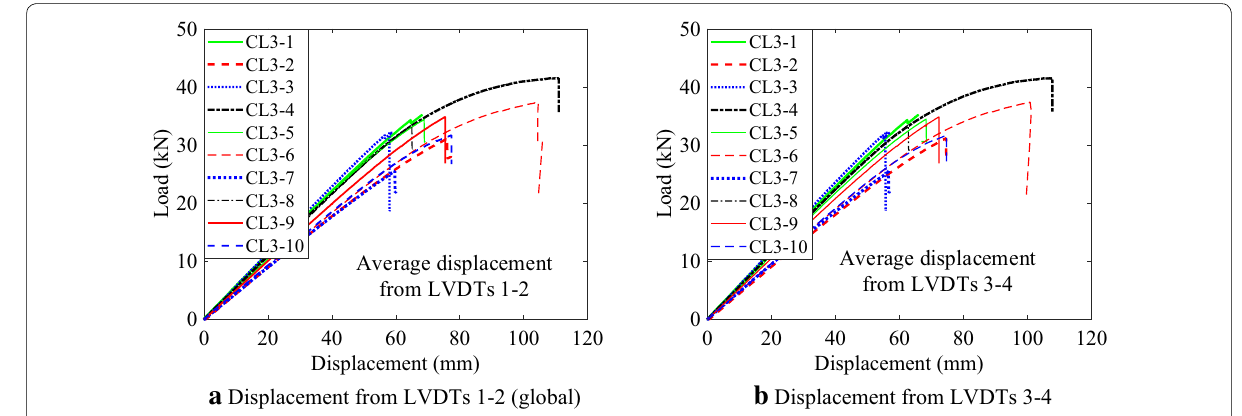
Fig. 6 The 3-layer CLT bending